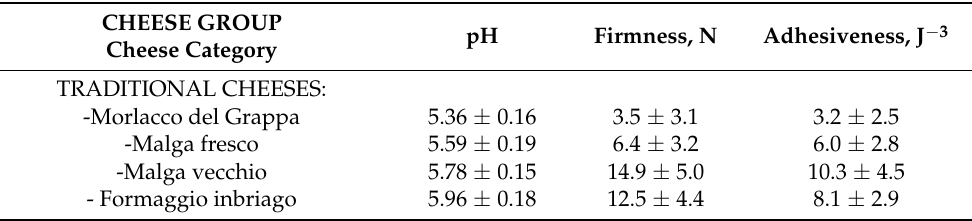
Table 10. Acidity and textural traits of the non-PDO cheese categories (averages and standard deviations by cheese